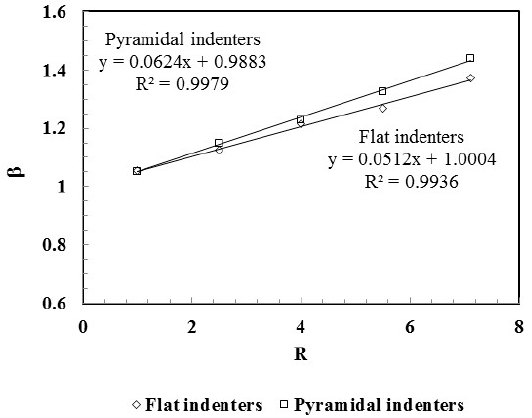
Figure 12. Evolution of 𝛽 as a function of the R-ratio obtained in numerical simulations using the five flat and pyramidal indenters with different values of the R-ratio.